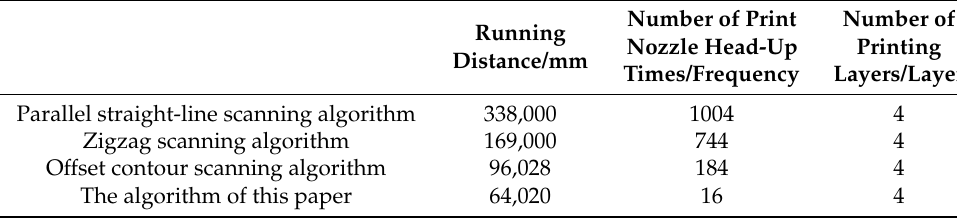
Table 1. Data collected in simulation